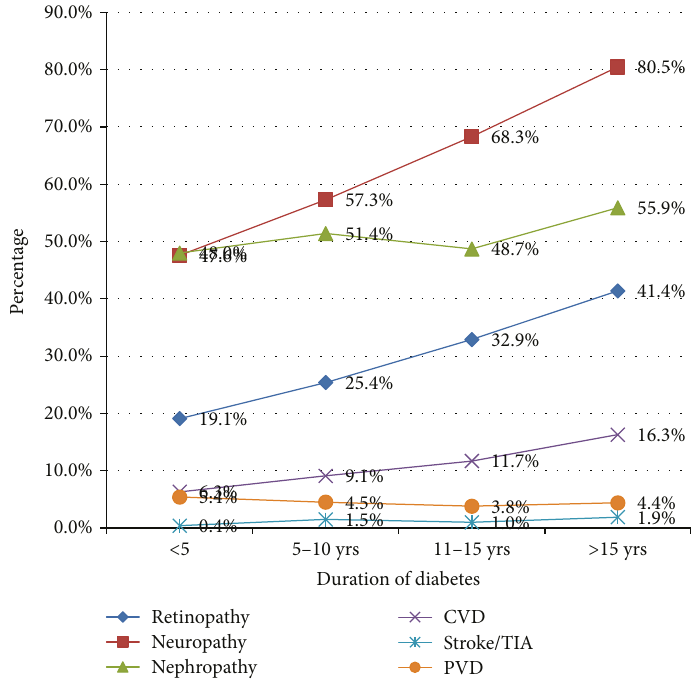
Figure 3: Variation of chronic complications with disease duration among 3000 patients with type 2 diabetes. Table 3: Logistic regression analysis showing risk factors which were signi fi cantly associated with chronic complications.